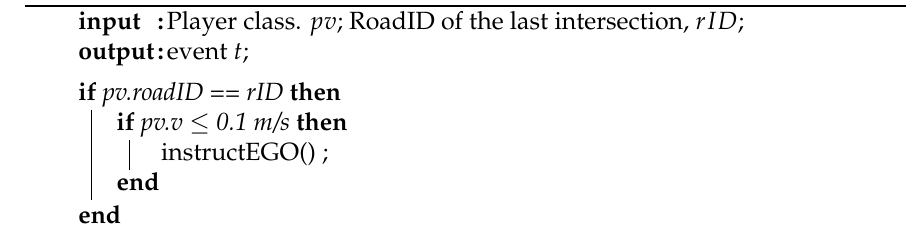
Algorithm 1 Trigger for Activating the EGO